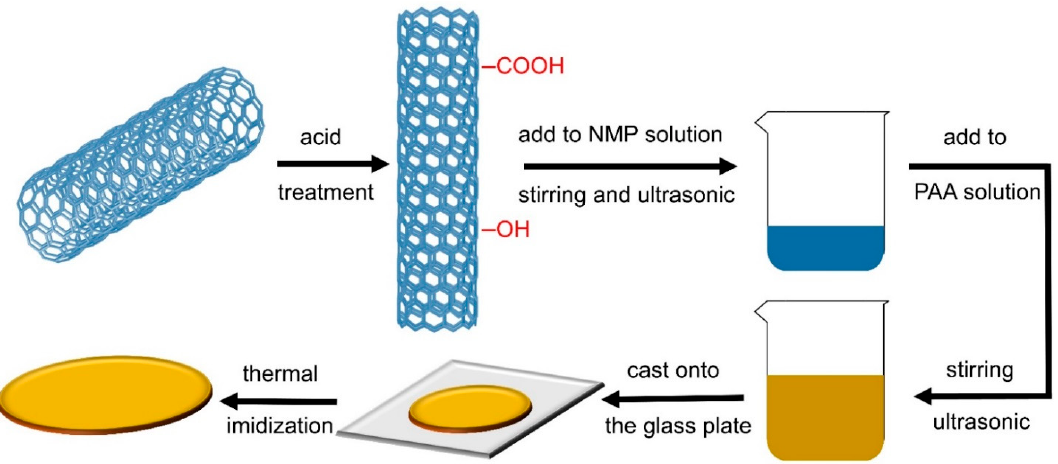
Figure 1. Preparation procedures of films.